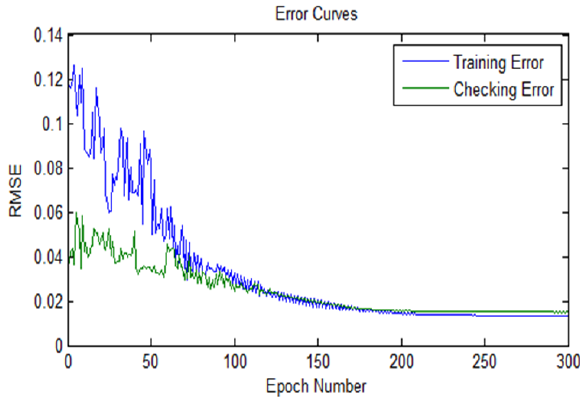
Figure 4. RMSE for training and test data CL prevalence rate in 2012 that the aforementioned model predict in evaluation stage is depicted in Figure (5).